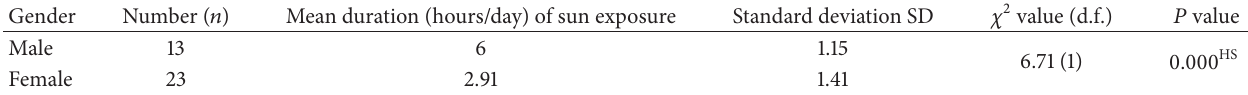
Table 3: Sex-wise comparison of duration of sun